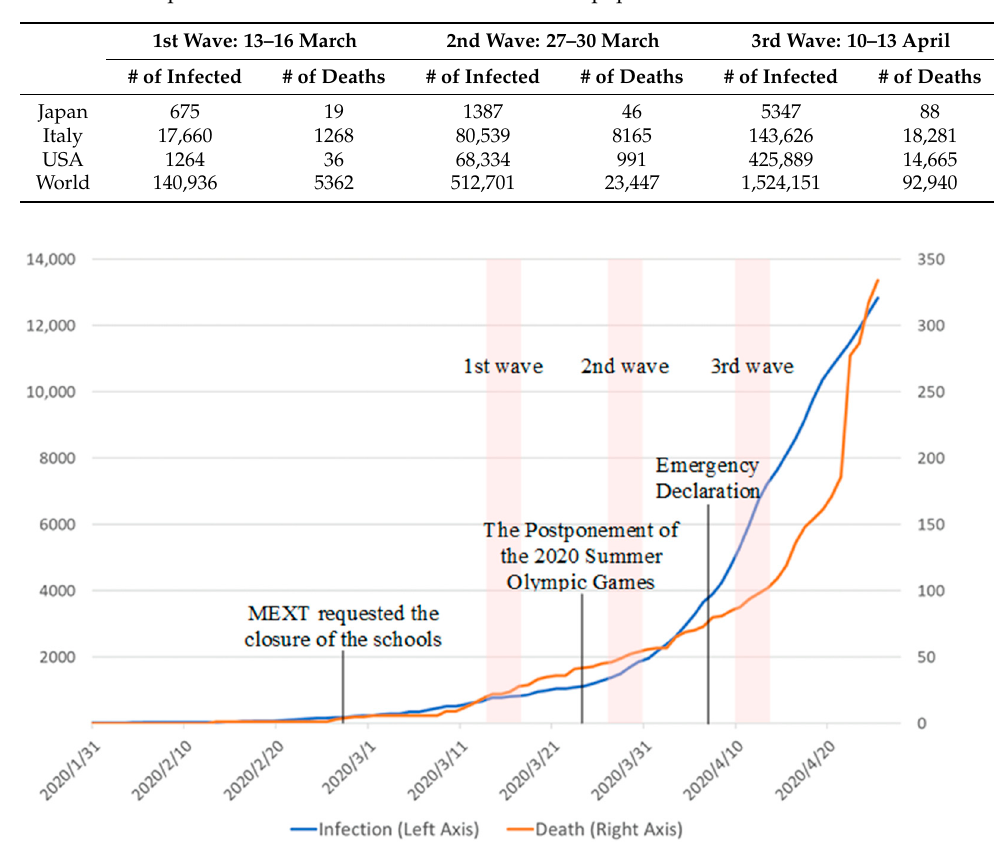
Table 1. Descriptive statistics of the variables used in this paper: each wave.